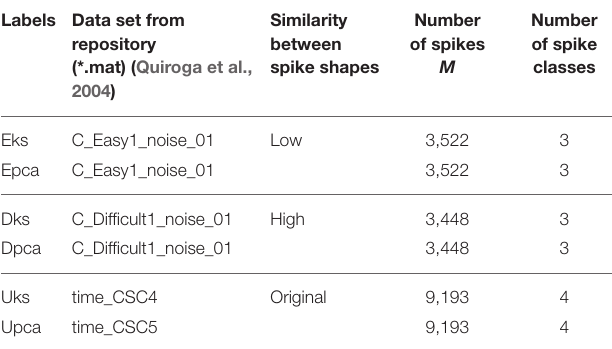
TABLE 1 | Details of labels used in the report for referring to a data set and its corresponding feature-set. Labels Data set from repository (*.mat) (Quiroga et al.,